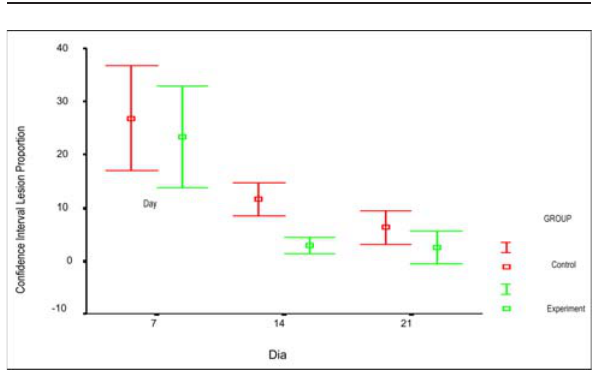
FIGURE 1 - Significant difference, between the lesion proportion and time, in Groups G1 I and G2